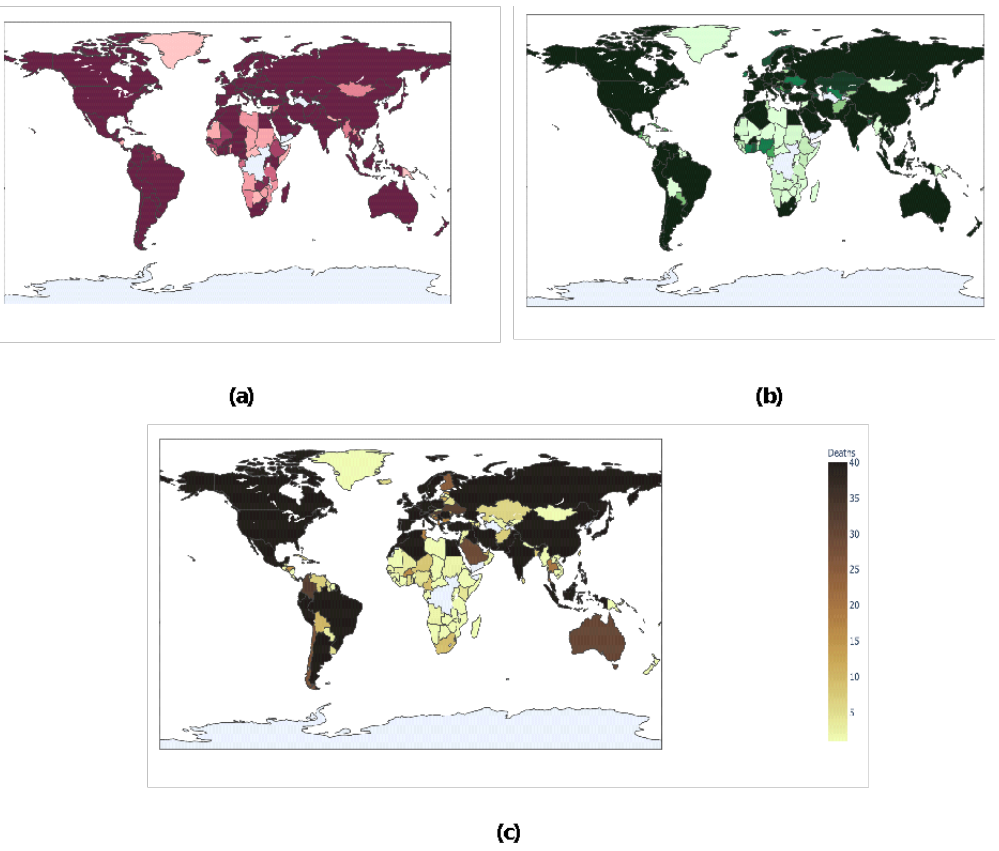
Figure 7. Heat Maps showing the number of ( a ) confirmed cases; ( b ) recovered cases; and ( c ) death cases across the world.